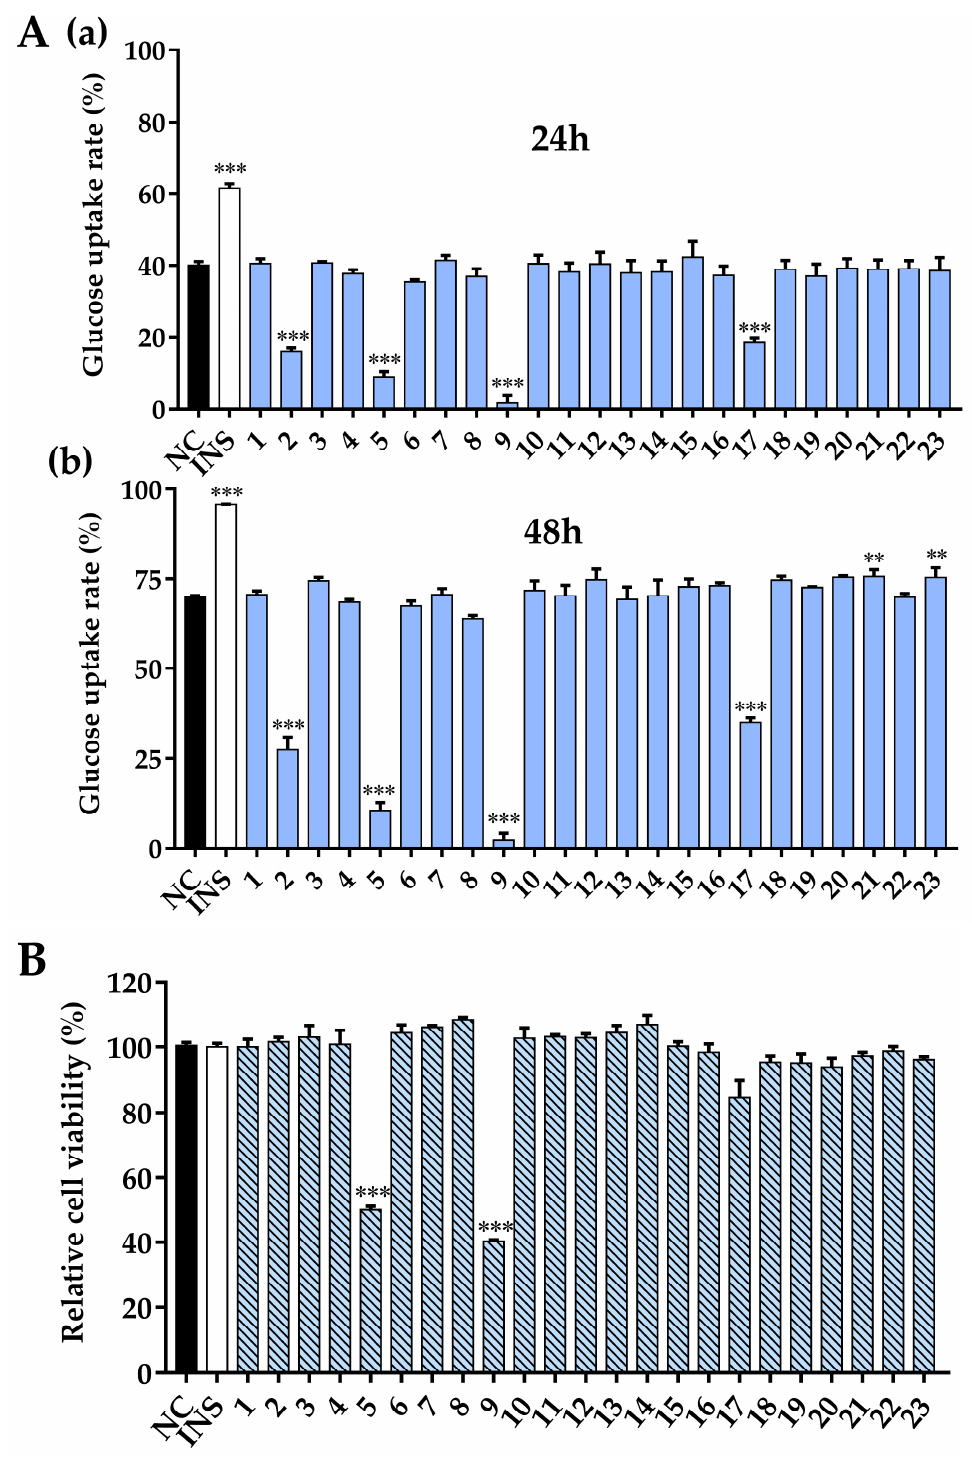
Figure 11. Glucose uptake and cell viability of 3T3-L1 adipocytes treated with T. grandis compounds. ( A ) Glucose uptake rate of different groups ( 1 – 23 ). Insulin and berberine were used as positive controls. ( B ) Cell viability of different groups. All values are mean ± SD from three independent experiments. Significance is denoted by symbols: ** p < 0.01, and *** p < 0.001. NC: blank control group, INS: positive control group, 1 – 23 : sampling group.